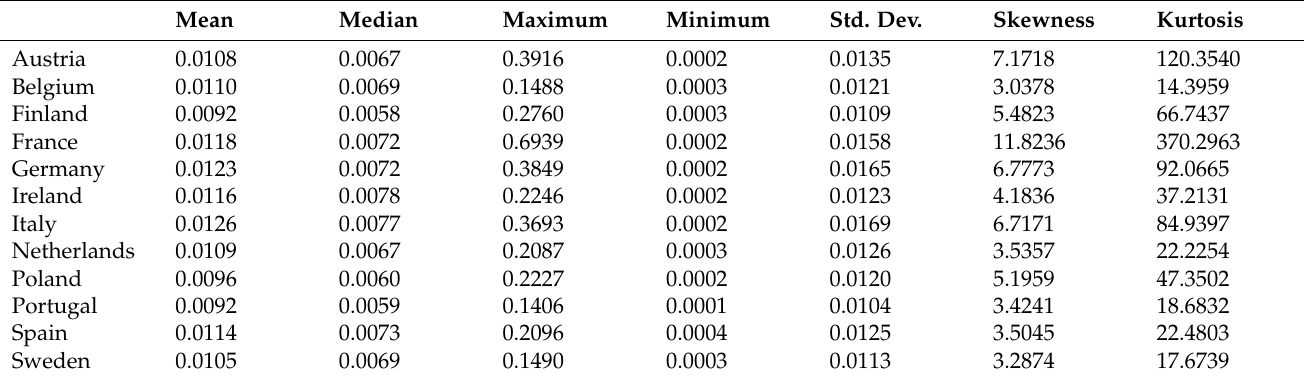
Table 2. Descriptive Statistics of stock market